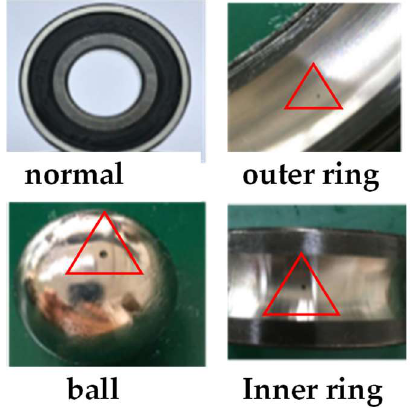
Figure 4. different types of fatigue pitting bearings.